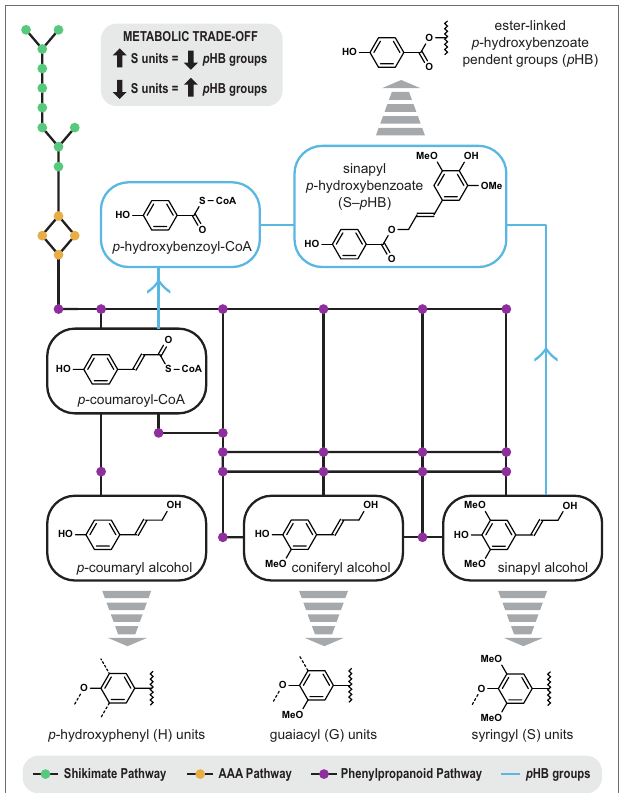
FIGURE 3 | Biosynthetic map depicting the metabolic relationship between the formation of p -hydroxybenzoate groups (blue) and the monolignols via the shikimate pathway (green), the aromatic amino acid pathway (AAA, yellow), and the phenylpropanoid pathway (purple). p -Coumaroyl-CoA is a common precursor that links syringyl lignin units and p -hydroxybenzoate groups in a metabolic trade-off. A significant negative correlation was observed between cell-wall-bound p -hydroxybenzoate (from 0.9 to 35 mg/g lignin) and syringyl lignin (62.8 to 79.2%) amongst 316 unrelated genotypes of Populus trichocarpa